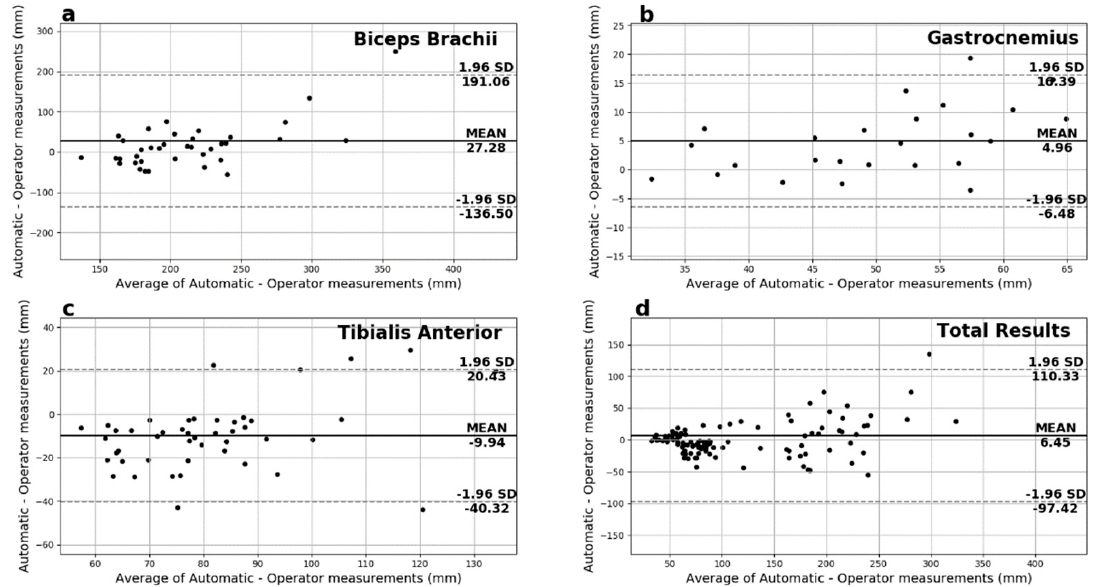
Figure 10. Fascicles Length’s Bland − Altman plots for ( a ) biceps brachii, ( b ) gastrocnemius medialis, ( c ) tibialis anterior, and ( d ) overall.